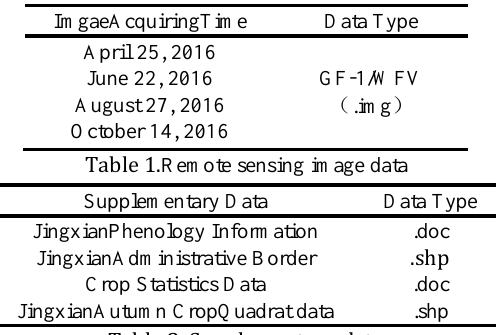
Table 2. Supplementary data